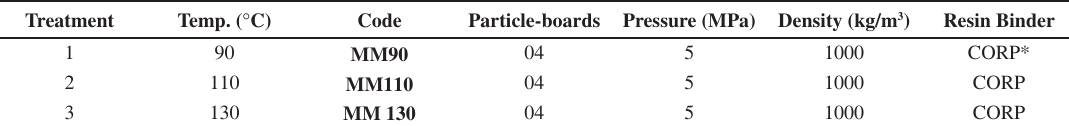
Table 1. Treatment proposed for the manufacture of particleboards. Treatment